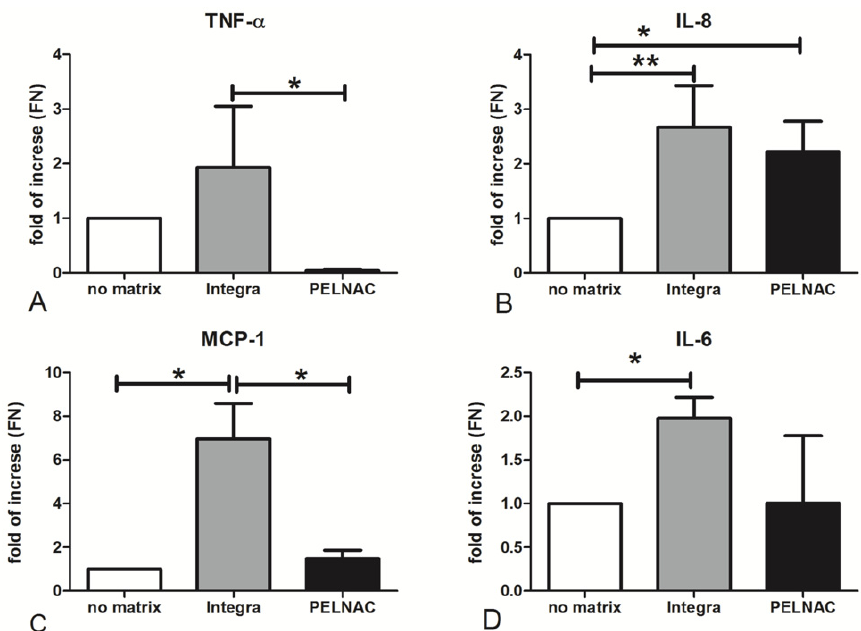
Figure 5. ( A – D ) RT-qPCR of TNF, IL8/CXCL8, MCP1/CCL2 and IL6 expressed by ADMECs cultured onto different matrices. Data represent the mean ± SE of duplicate samples from three separate experiments: * p < 0.05, ** p < 0.01.